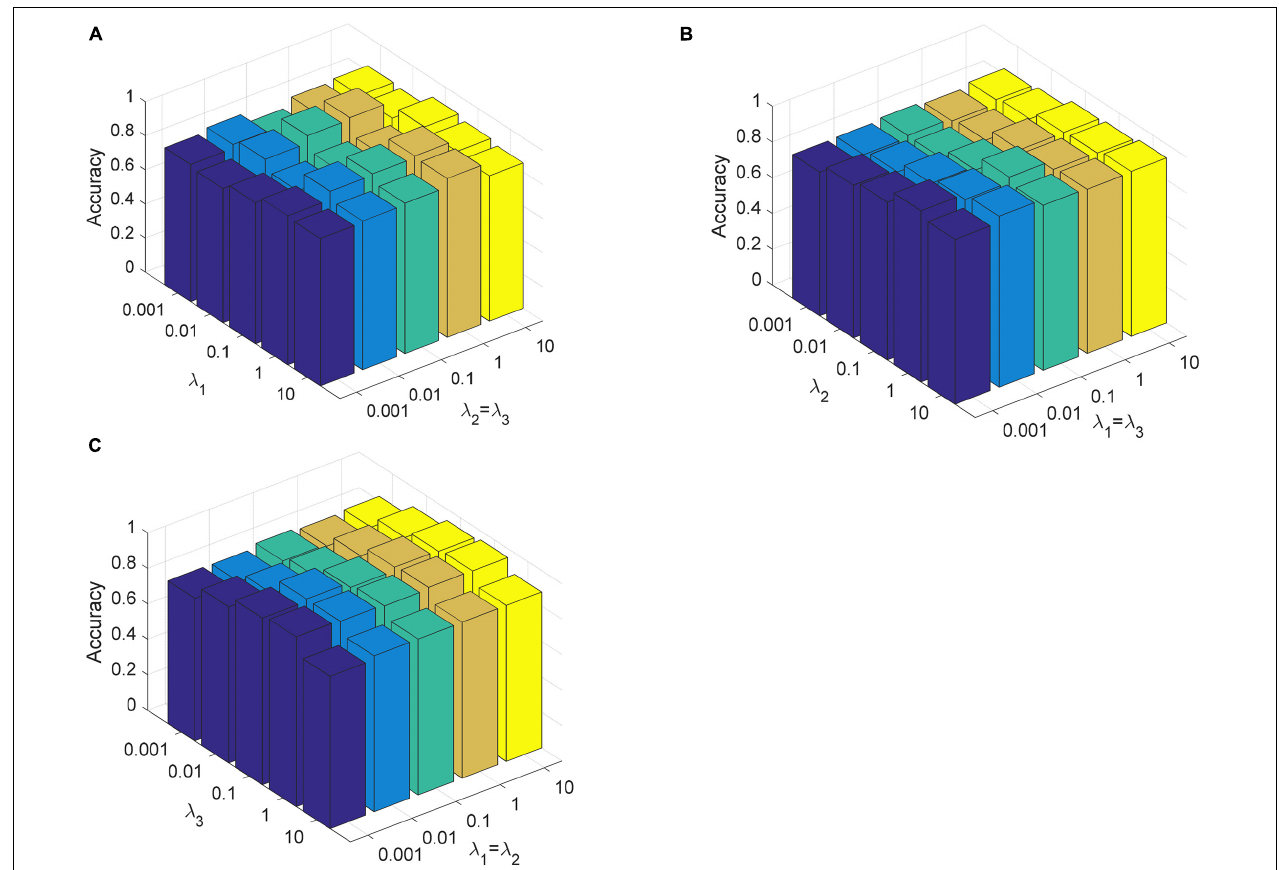
and λ ( λ ), (B) λ and λ ( λ ), and (C) λ 1 2 3 2 1 3